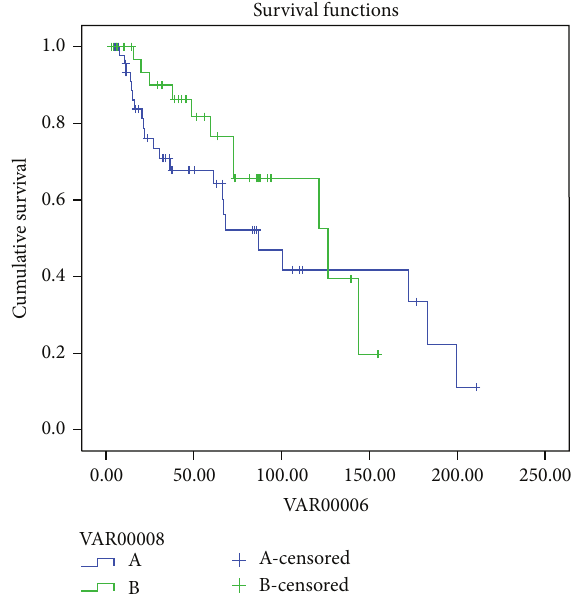
Figure 3: Patients survival PDF (green) and HDPD (anuric) (blue) (log rank 𝑃 = 0.31